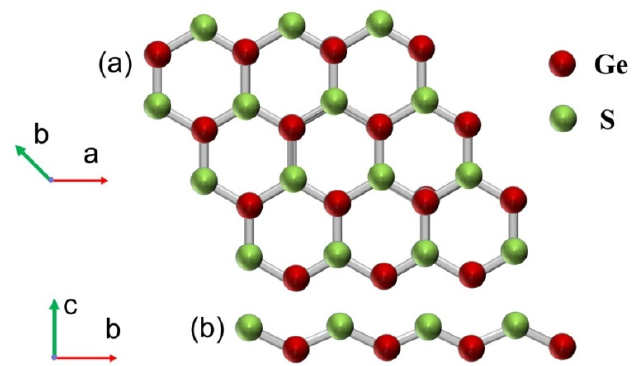
Figure 1. Three-dimensional representation of the structure of GeS: ( a ) top view ( b ) side view.